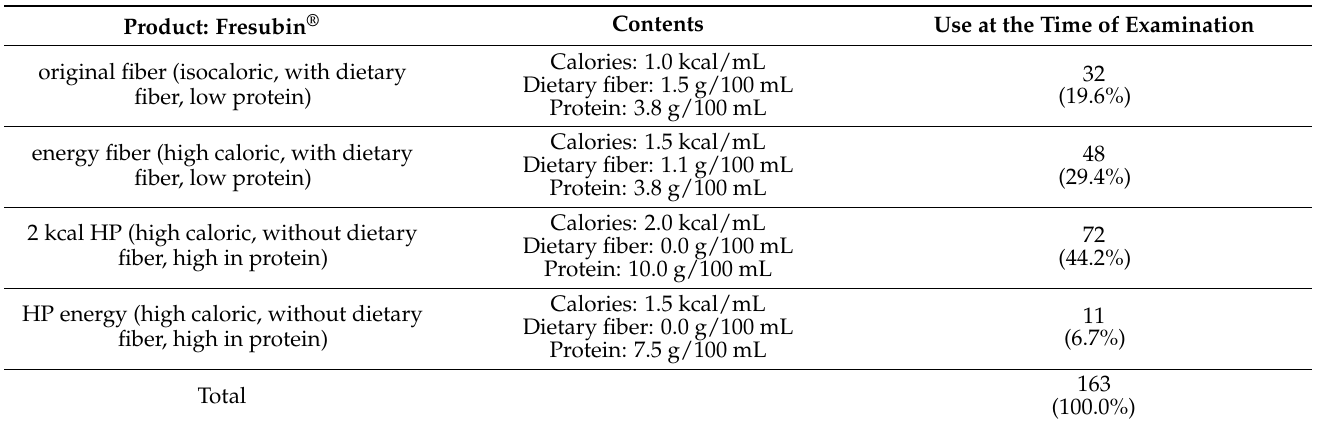
Table A1. Characteristics [42] and use of nutritional products at the time of study.